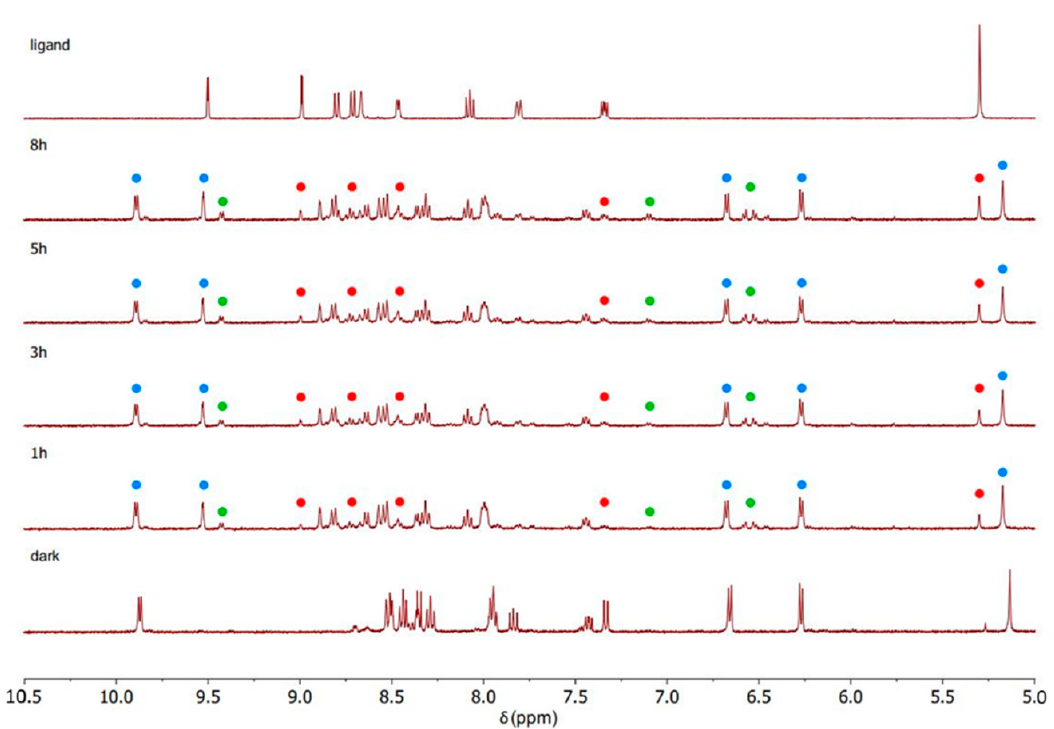
Figure 5. 1 H NMR spectra recorded during the photoactivation of complex C1 with blue light (420 nm) in DMSO-d 6 .